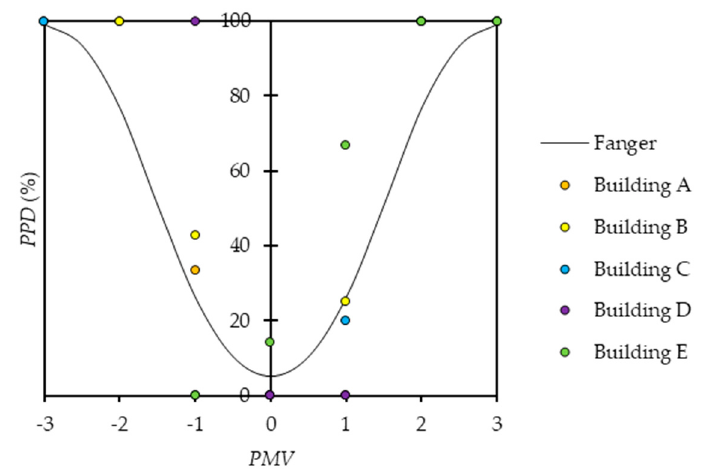
Figure 9. Indoor climate questionnaire results for indoor air temperature. The descriptions of y-axis are the room air temperature sensation question (upper) and verification questions (middle and lower) from the indoor climate questionnaire (see Appendix A).